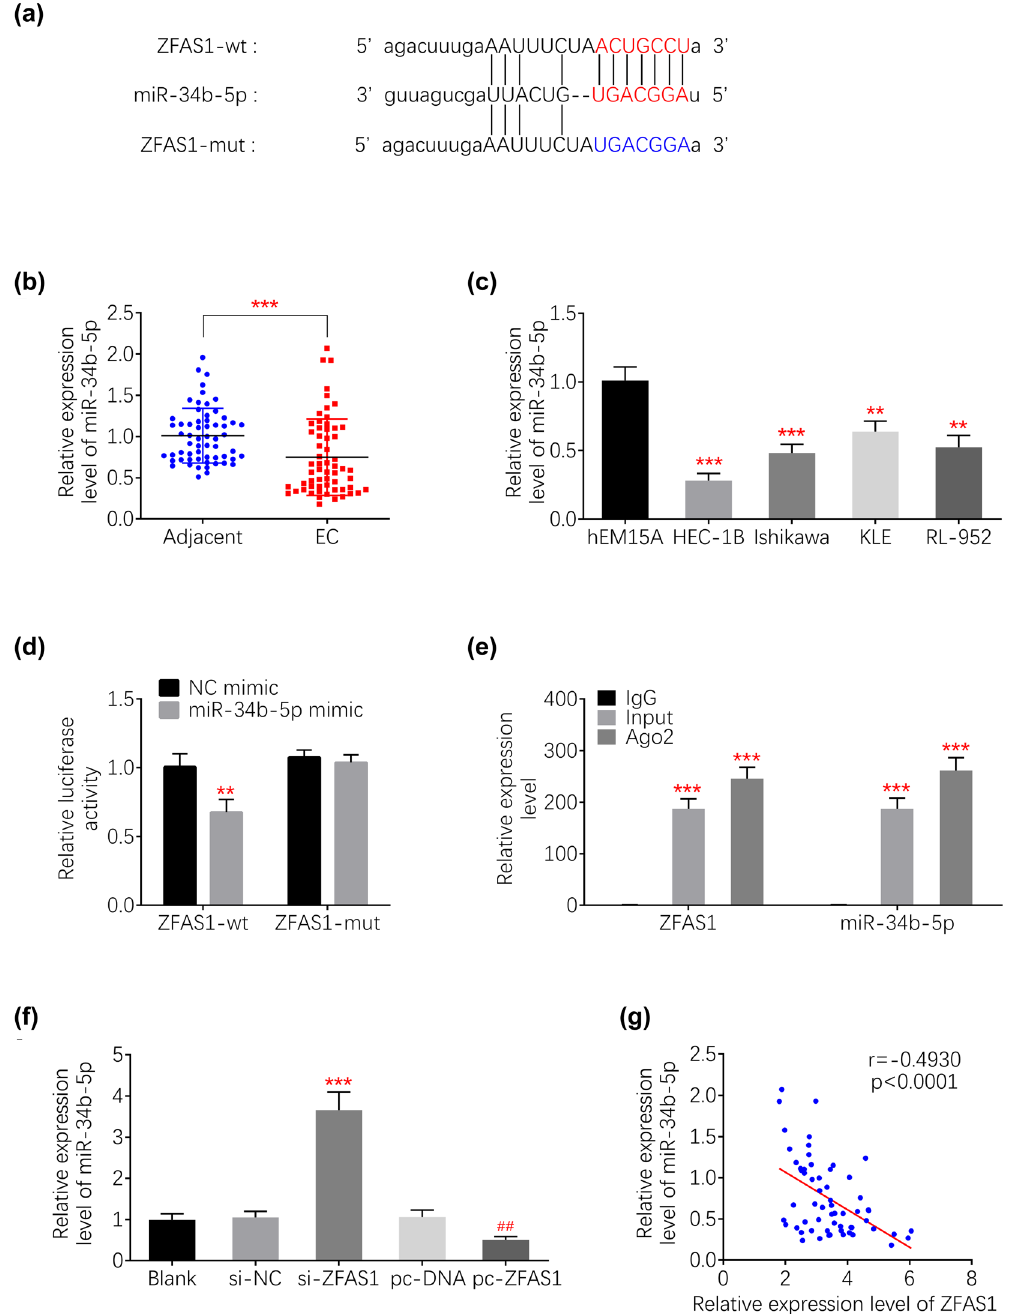
Figure 3: ZFAS1 bind to miR - 34b. ( a ) Potential binding site between ZFAS1 and miR - 34b. ( b ) miR - 34b was reduced in the endometrial carcinoma tissues compared to adjacent tissues. ( c ) miR - 34b was reduced in the endometrial carcinoma cell lines ( HEC - 1B, Ishikawa, KLE and RL - 952 ) compared to hEM15A. ( d ) miR - 34b mimic decreased activity of wild type pmirGLO - ZFAS1, while it had no signi fi cant e ff ect on mutant pmirGLO - ZFAS1. ( e ) Expression of miR - 34b was decreased in HEC - 1B transfected with si - ZFAS1#2, while increased by pcDNA - mediated over - expression of ZFAS1. ( f ) Negative correlation between ZFAS1 and miR - 34b in endometrial carcinoma tissues. **, ## p < 0.01 and *** p <